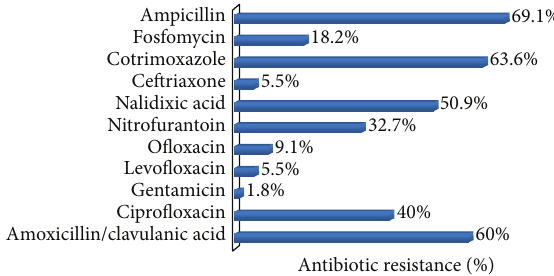
Figure 2: Prevalence of antibiotic resistance (%) among